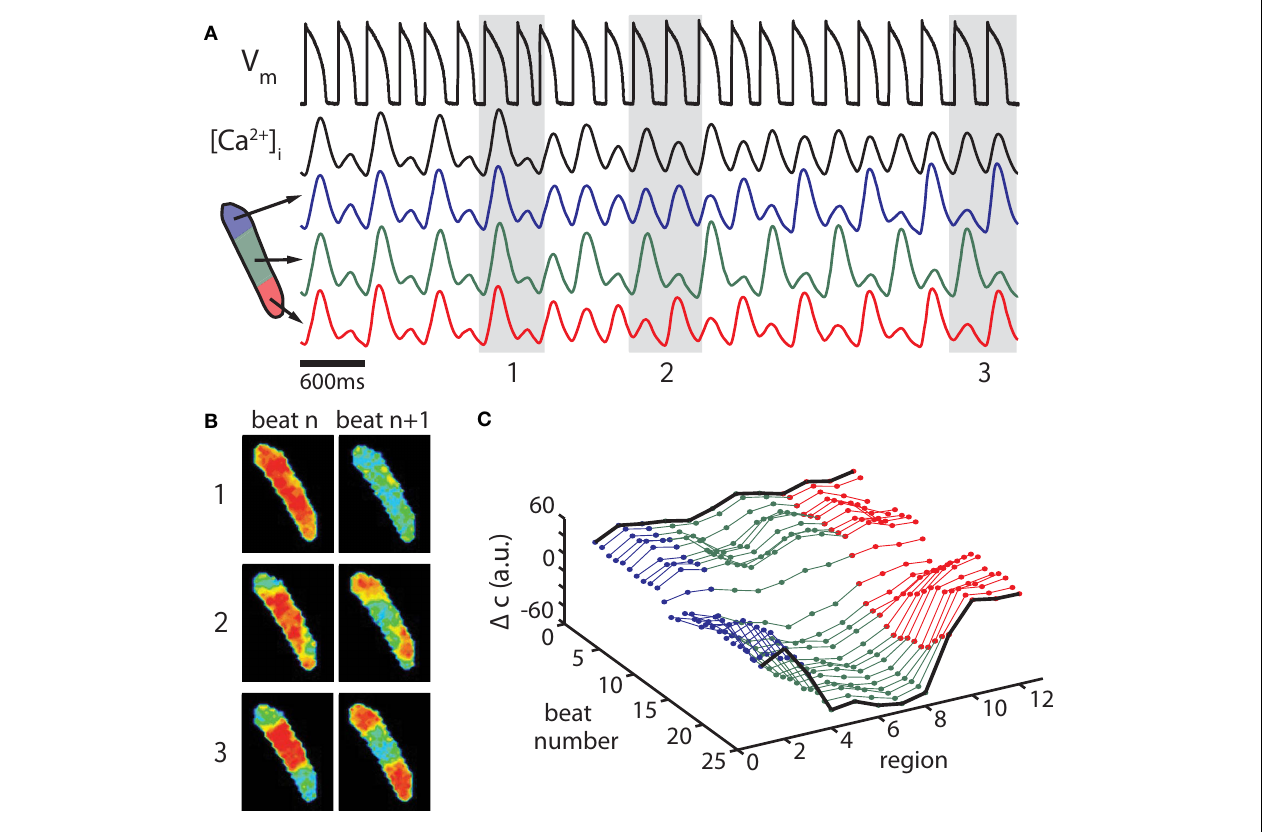
marked by gray shaded regions in (A) . (C) Ca 2 + -alternans magnitude along the length of the cell is plotted for the experiment shown in (A) . For this panel, fluorescence data are binned into 12 adjacent regions perpendicular to the length of the cell and the average Ca 2 + -alternans magnitude ( Δ c ) is plotted for each region for the 25 beats shown (arbitrary fluorescence units), with colors corresponding to the regions diagrammed in (A) . Fluorescence data from the extreme ends of the cell are excluded due to motion artifact. Experiments shown are from a cell paced at a cycle length of 300ms (with alternans control). Adapted from Gaeta et al.